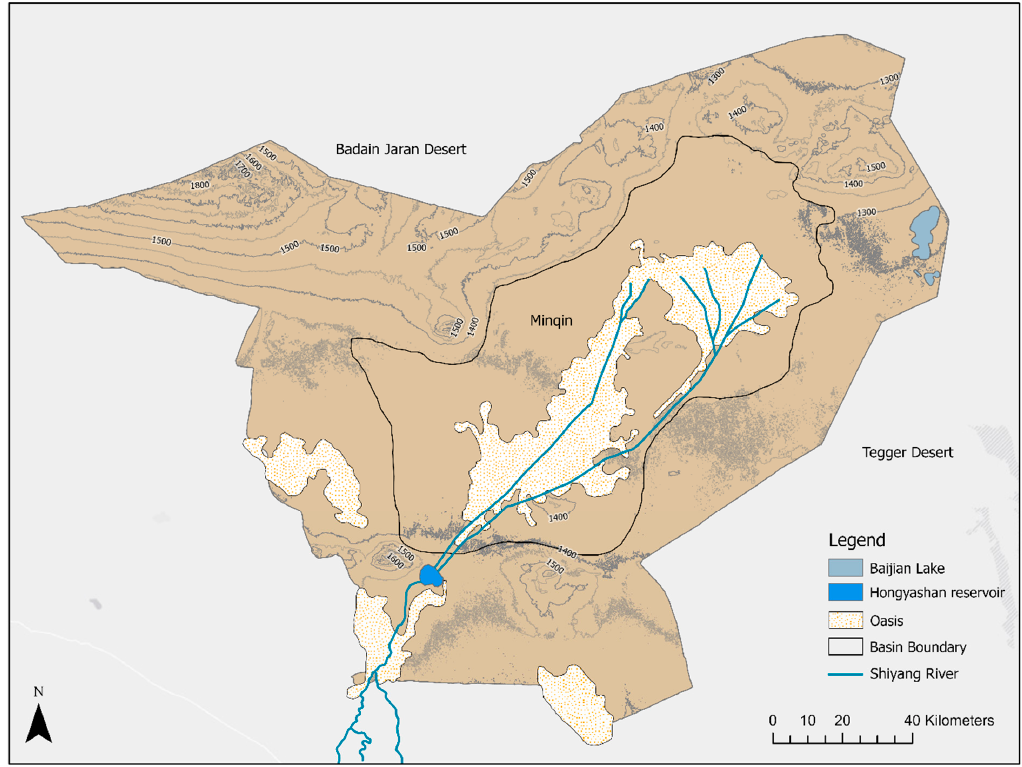
Figure 4. Minqin Basin (own figure, data and information based on [23,29]).